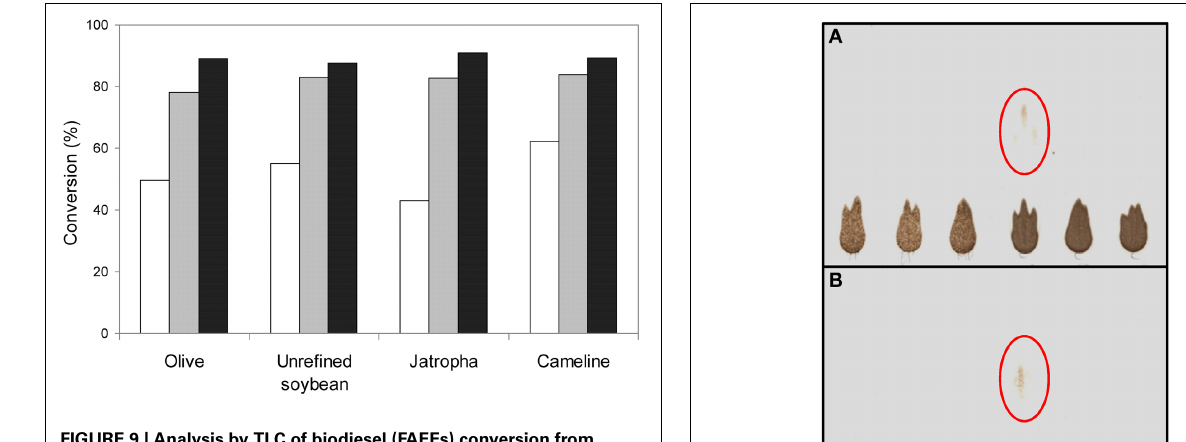
FIGURE 9 | Analysis by TLC of biodiesel (FAEEs) conversion from different non-edible vegetable oils catalyzed by magnetic biocatalysts of CALB. The reaction mixture containing 0.2g oil, 2-propanol (6:1 alcohol:oil molar ratio) and 1% (w/w of oil) of catalyst was incubated for 72h at 30 ◦ C with rotational mixing. MNP-CALB (white bars), mCLEA-CALB with 25 μ g protein/mg MNP (gray bars), and mCLEA-CALB with 100 μ g protein/mg MNP (black bars). Olive oil was used as a control.